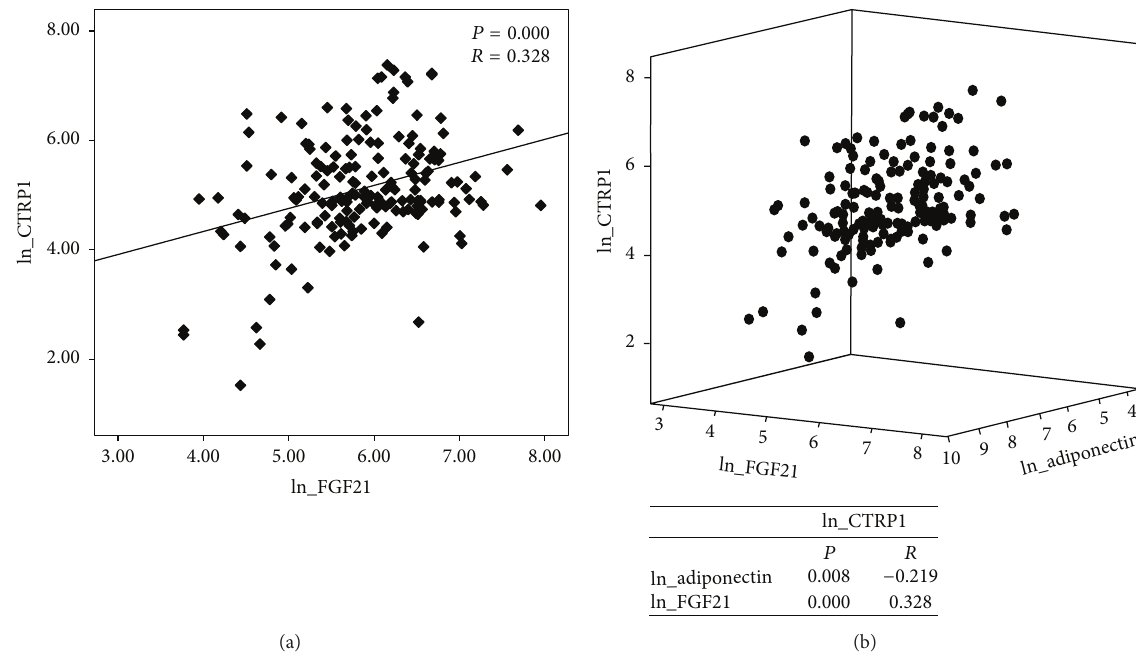
Figure 2: Correlation between circulating CTRP1 and DM-related cytokines. Circulating levels of CTRP1, FGF21, and adiponectin were measured in human sera. (a) Correlation analyses between circulating levels of CTRP1 and FGF21 in sera. (b) Correlation analyses between circulatinglevelsofCTRP1,FGF21,andadiponectininseraareshowedin3-dimensionaldotplot(upper)andcorrelationcoefficient(bottom). Correlations between indicated groups were analyzed using a generalized linear model. ln, natural logarithm.